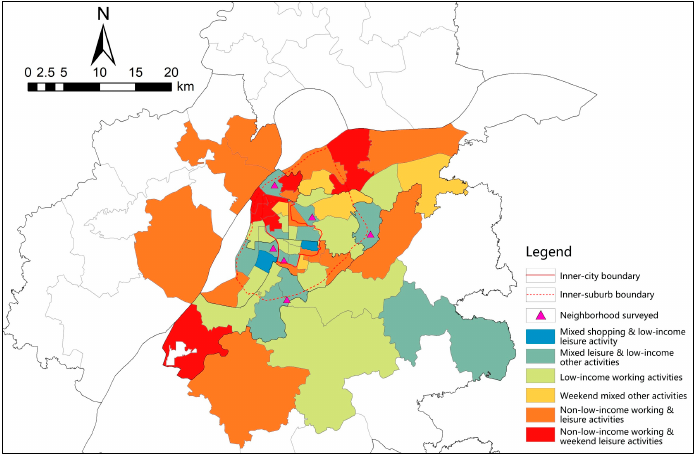
( f ) ( g ) Figure 2. Spatial distribution of scores of seven main factors. ( a ) F1: Mixed leisure and low-income-